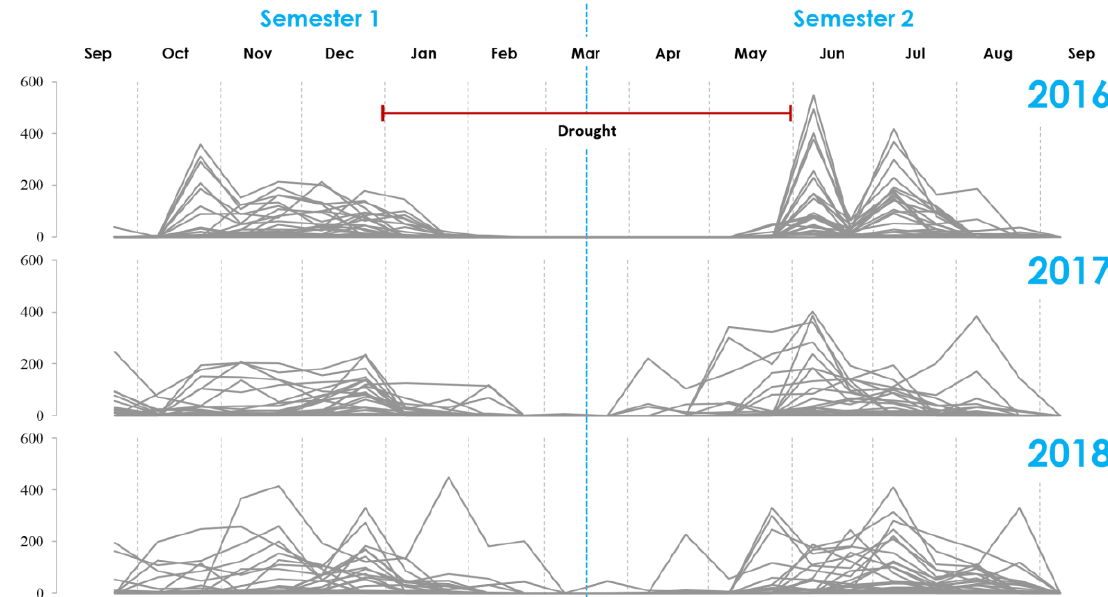
Figure 9. Drought duration (2016) and provincial rice planting window in Mindanao,